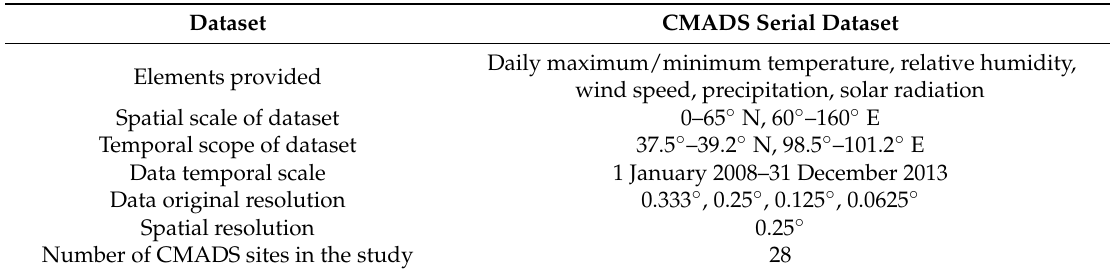
Table 1. The CMADS information.